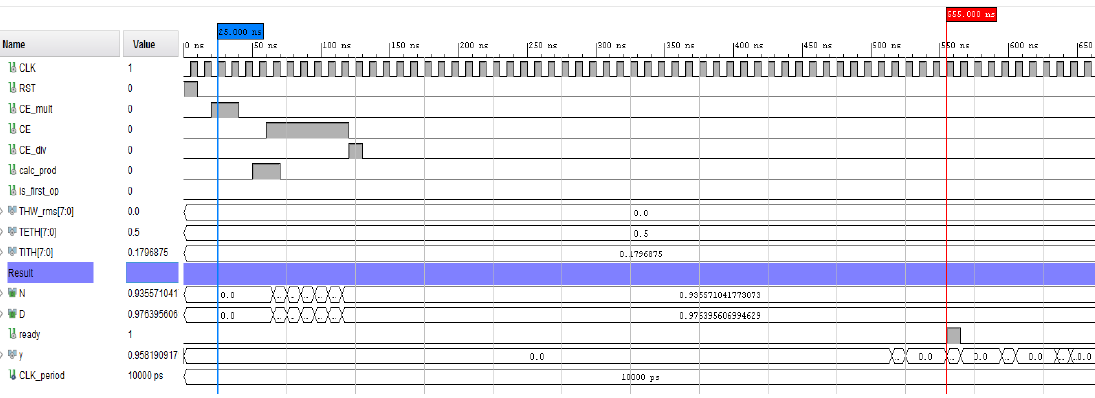
Figure 12. Simulation results of the ANFIS Cluster 1 HW accelerator obtained with the Vivado design